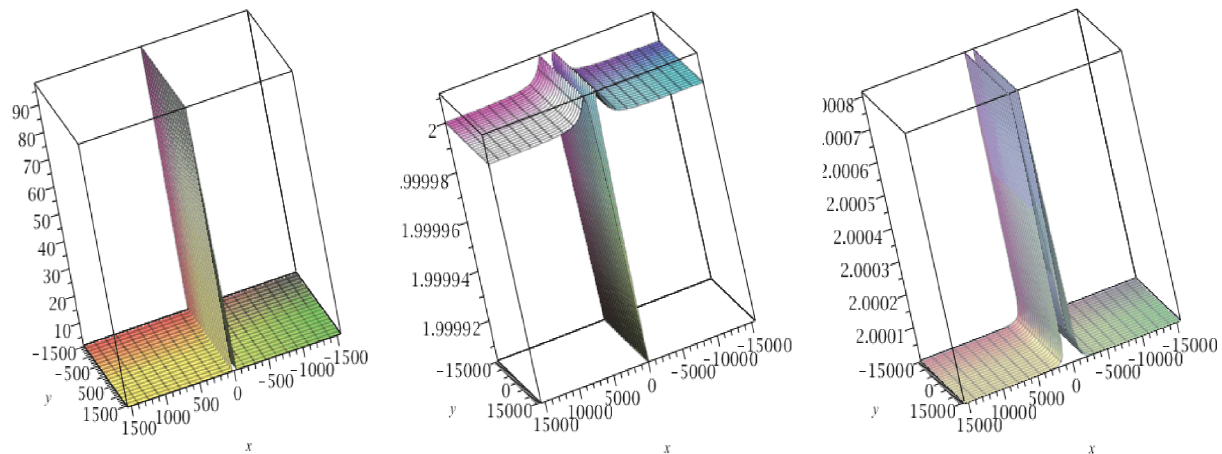
Figure 1: Solution of order 3 to (1), on the left for 𝑡 = 0 , 𝑎 1 = 0 , 𝑏 1 = 0 , 𝑎 2 = 0 , and 𝑏 2 = 0 ; in the center for 𝑡 = 0 , 𝑎 1 = 10 3 , 𝑏 1 = 0 , 𝑎 2 = 0 , and 𝑏 = 0 ; and on the right for 𝑡 = 0 , 𝑎 2